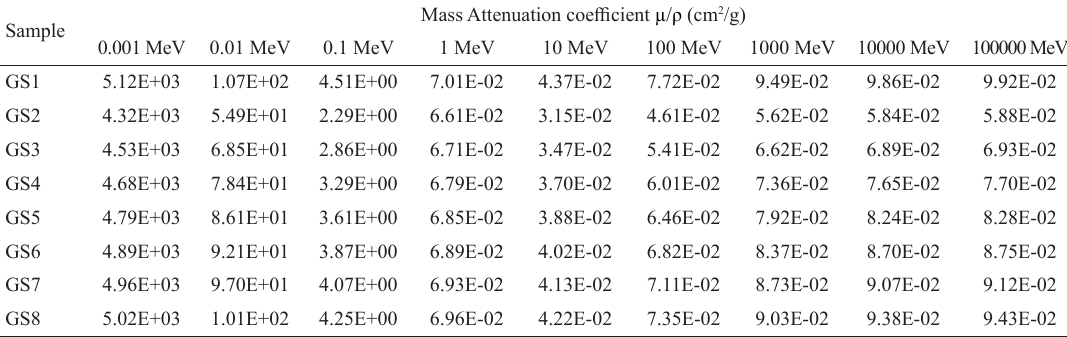
Mass Attenuation coefficient µ/ρ (cm 2 /g)